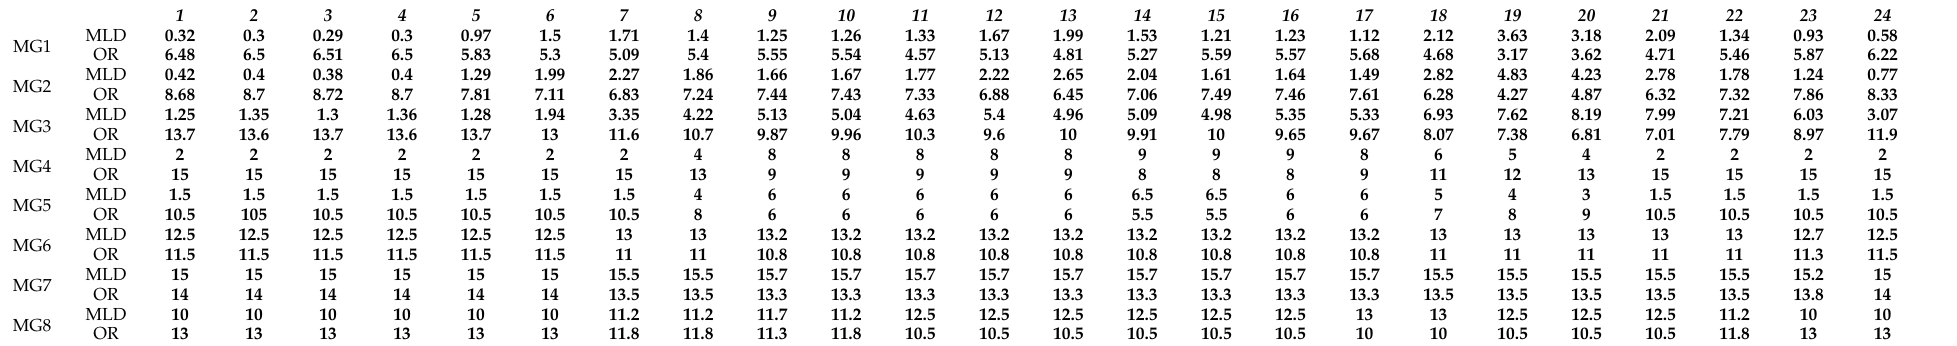
Table 2. Maximum load demand (MLD) and operating reserve (OR) of MGs for different step